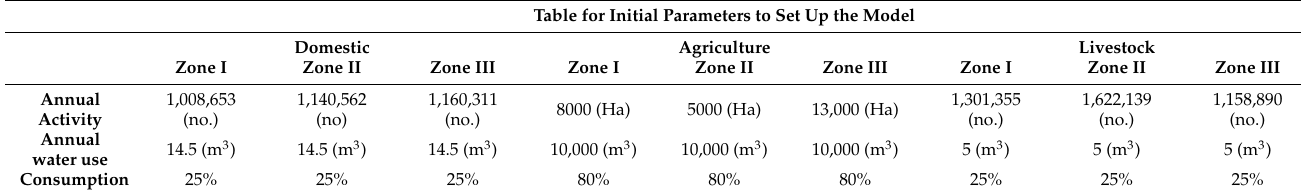
Table 2. Table for initial parameters to set up model. Table for Initial Parameters to Set Up the Model